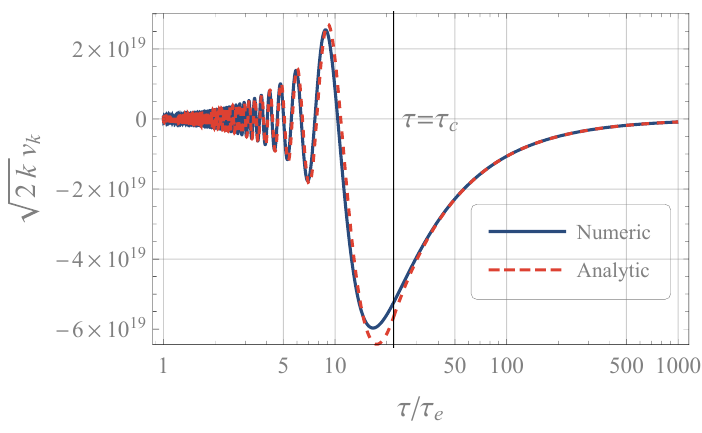
Figure 2 . Comparison between the numerical solution of eq. (3.2) and the analytic expression from matching eqs. (3.5) and (3.6) at τ = τ c . We have set R = 10 6 , p = 2 . 2 and − kτ e = 10 − 20 . The latter has been chosen such that the mode lies between k min and k max